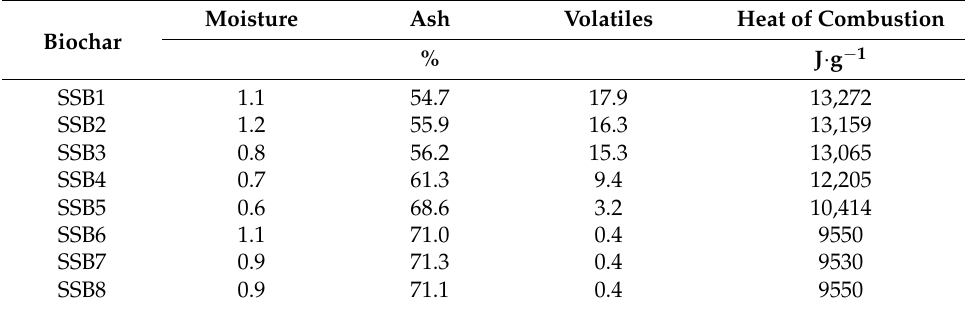
Table 7. Proximate analysis of